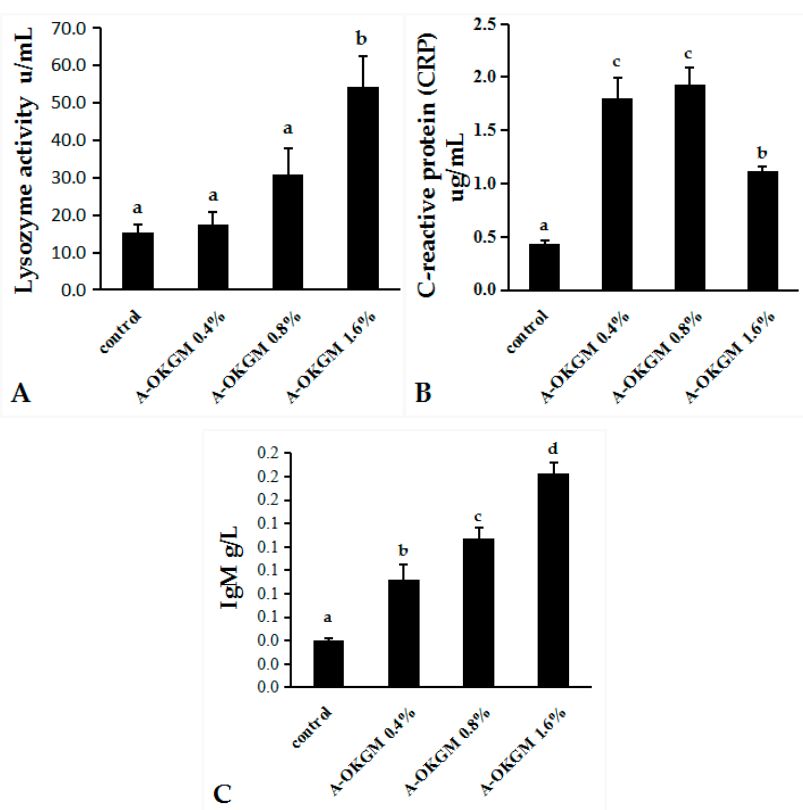
Figure 1. ( A ) Lysozyme activity, ( B ) C-reactive protein level and ( C ) IgM level of Schizothorax prenanti after consumption of the experimental diet. The observed values are expressed as the mean ± standard error (S.E). a–d Means with different superscripts are significantly ( p < 0.05) different from each other.